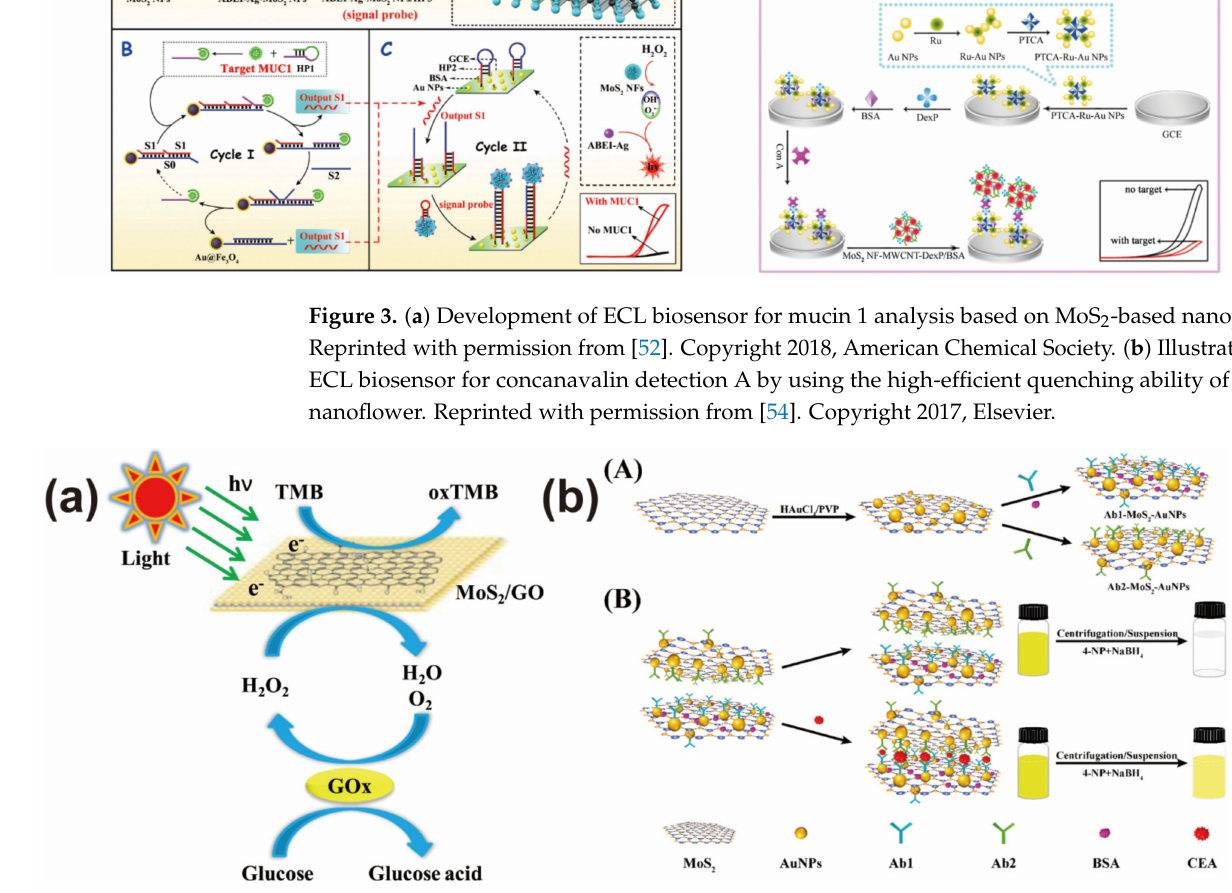
Figure 4. ( a ) Colorimetric analysis of glucose by coupling peroxidase-like MoS 2 -based nanoprobe and glucose oxidase. Reprinted with permission from [59]. Copyright 2016, Elsevier. ( b ) Construction of a MoS 2 -based colorimetric biosensor for carcinoembryonic antigen analysis. Reprinted with permission from [30]. Copyright 2018, American Chemical